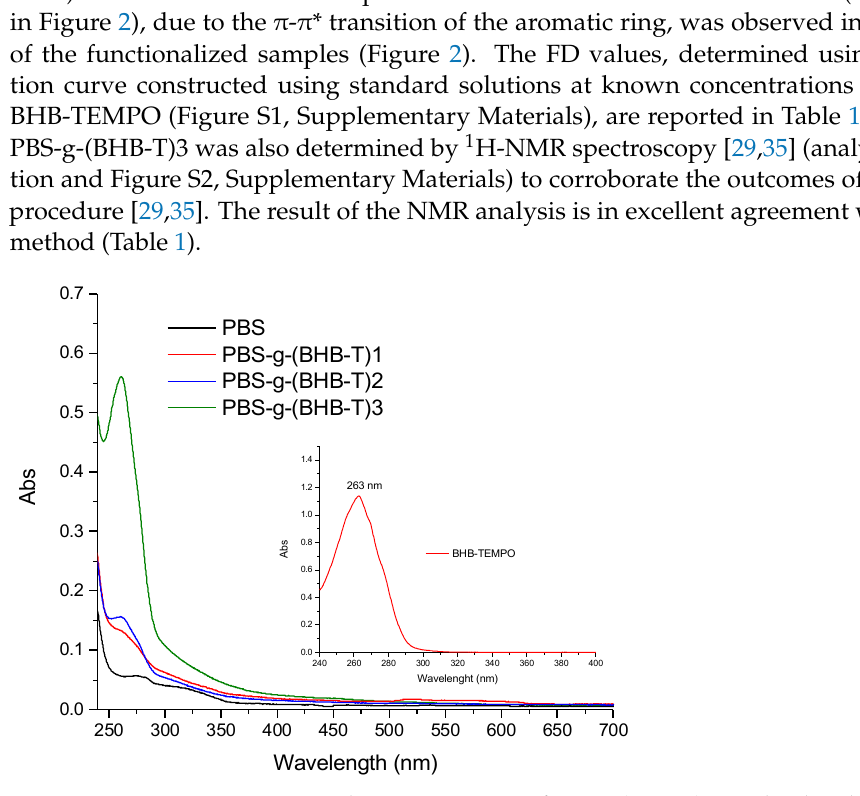
Figure 2. Representative UV-Vis absorption spectra of PBS-g-(BHB-T) samples dissolved in CHCl 3 . The inset shows the spectrum of BHB-TEMPO (CHCl 3 solution).